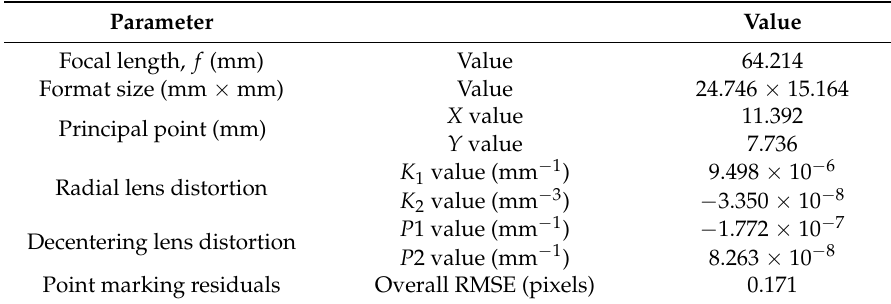
Table 1. Interior orientation parameters of visible camera Canon EOS 700D equipped with a 60 mm fixed focal lens, as a result of its geometric calibration.